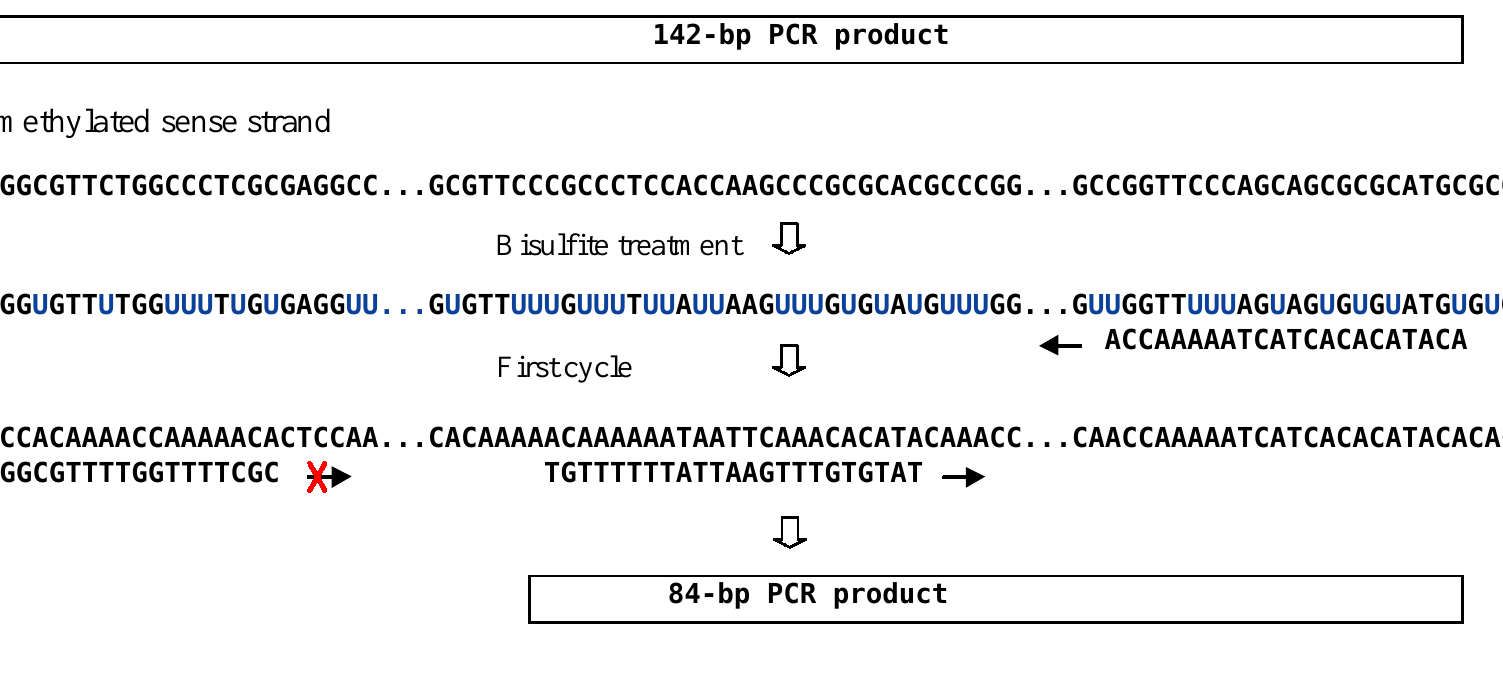
Figure 1 - Strategy for the methylation-specific PCR based on the methylation pattern of the FMR1 CpG island as described by Stöger et al. (1997). The methylated cytosines are shown in red and marked as asterisks. The non-methylated cytosines are converted into uracil residues (shown in blue) by the bisulfite treatment. This diagram is based on the one published by Zeschnigk et al. (1997) for the diagnosis of Angelman and Prader-Willi syndromes by